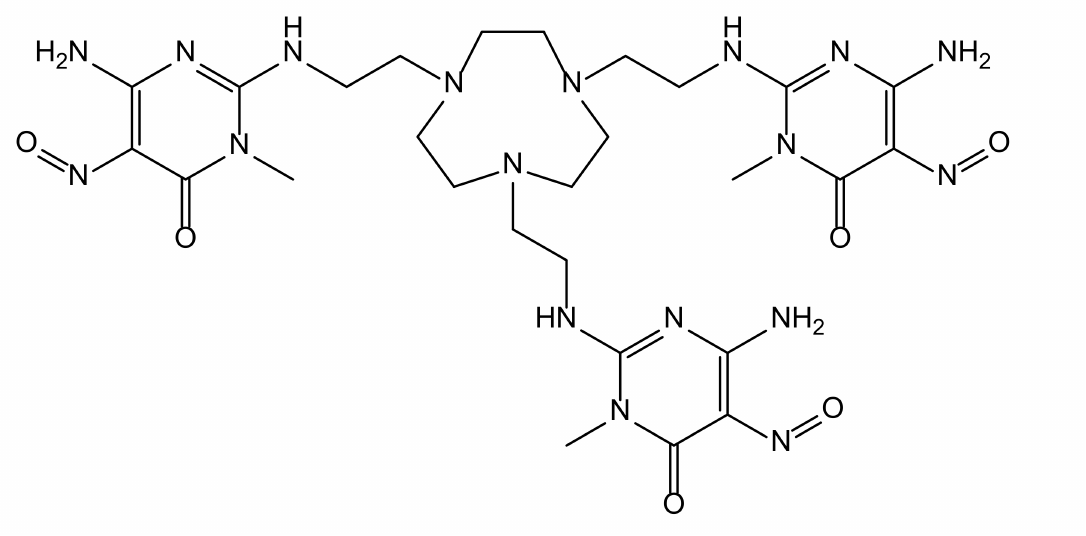
Figure 1. The H 3 L